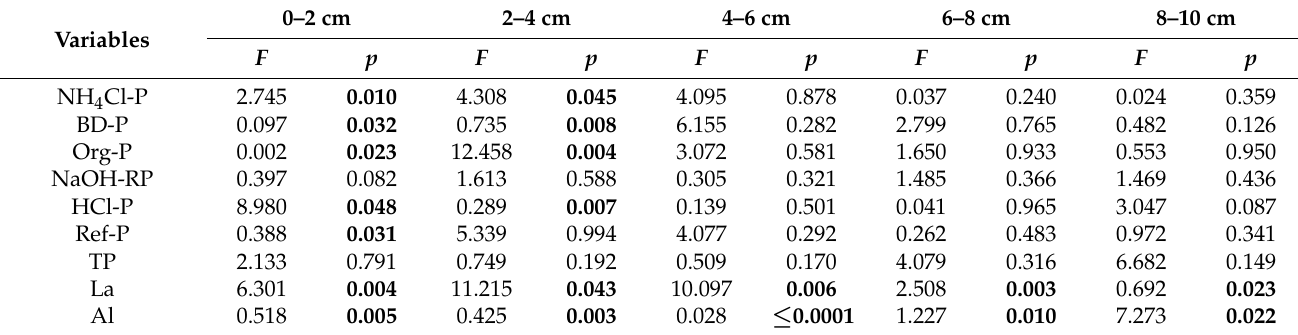
Table 2. Results of the Student’s t -test for the concentrations of labile-P (NH 4 Cl-P), reductant-soluble-P (BD-P), organic-P